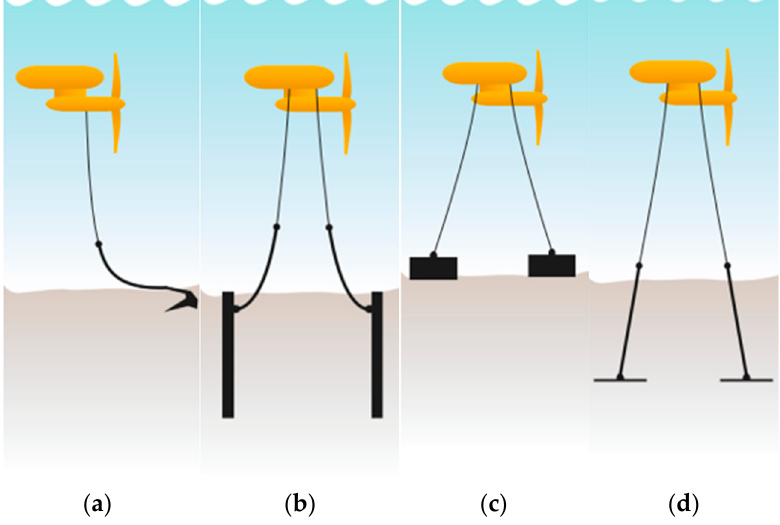
Figure 1. Types of foundations for ocean current turbine anchorage. ( a ) Fluke; ( b ) Pile; ( c ) Deadweight; ( d ) Plate.